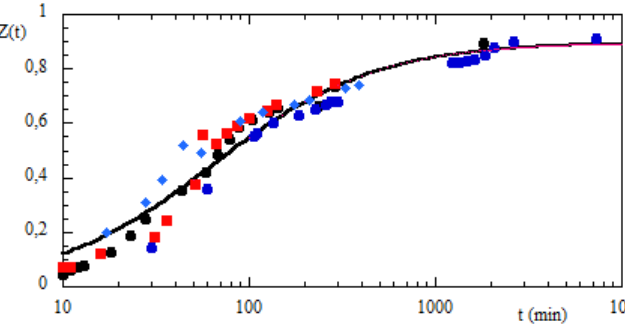
Figure 4. Master curve of clay material mixed with polyacrylamide. Samples from the Occhito reservoir.